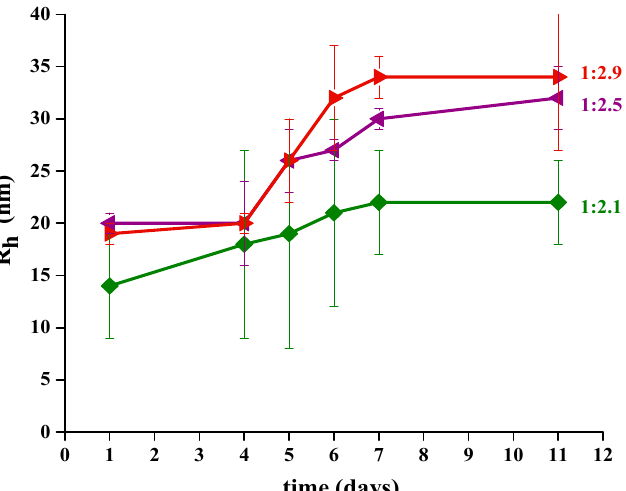
Figure 7. Hydrodynamic radius distribution over time of CeO 2 _OL_250 NPs with different molar ratio NPs:(NaOl × 10 6 ).